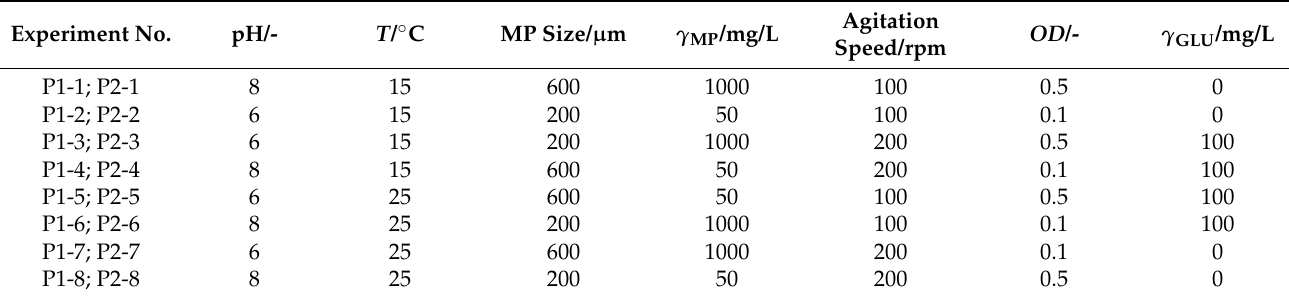
Table 1. Taguchi L 8 orthogonal array for each factor at 2 levels. Experiment No.